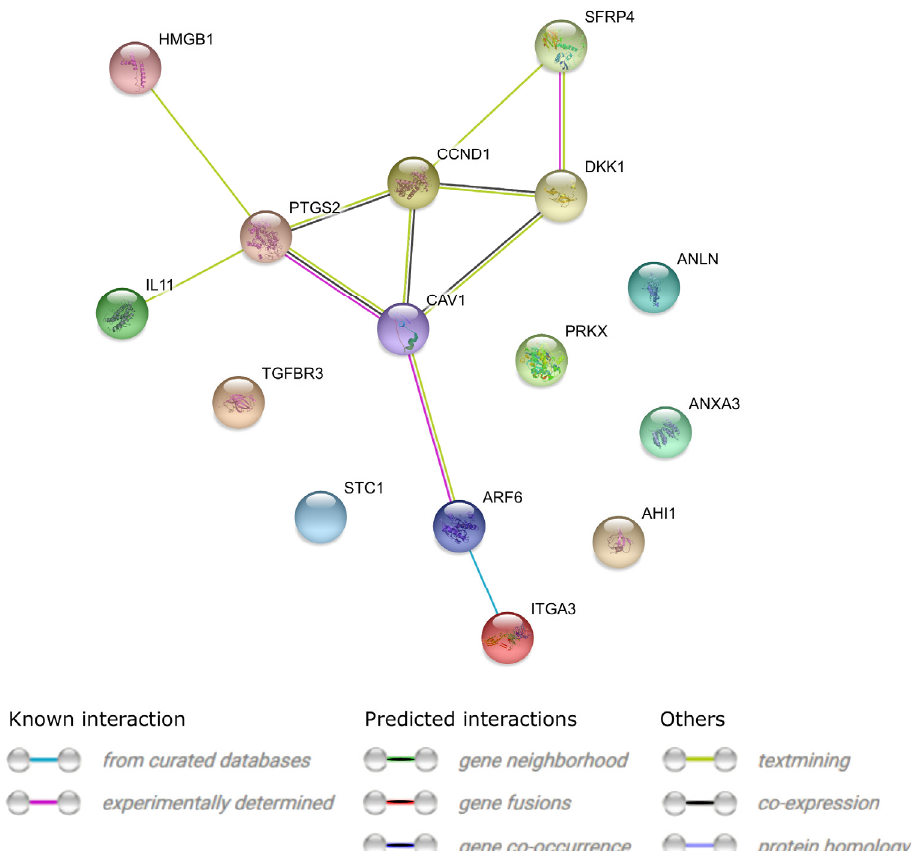
Figure 4. STRING-generated interaction occurrence between 15 chosen differentially expressed genes that belong to the selected GO BP terms. The intensity of the edges reflects the strength of the interaction score.